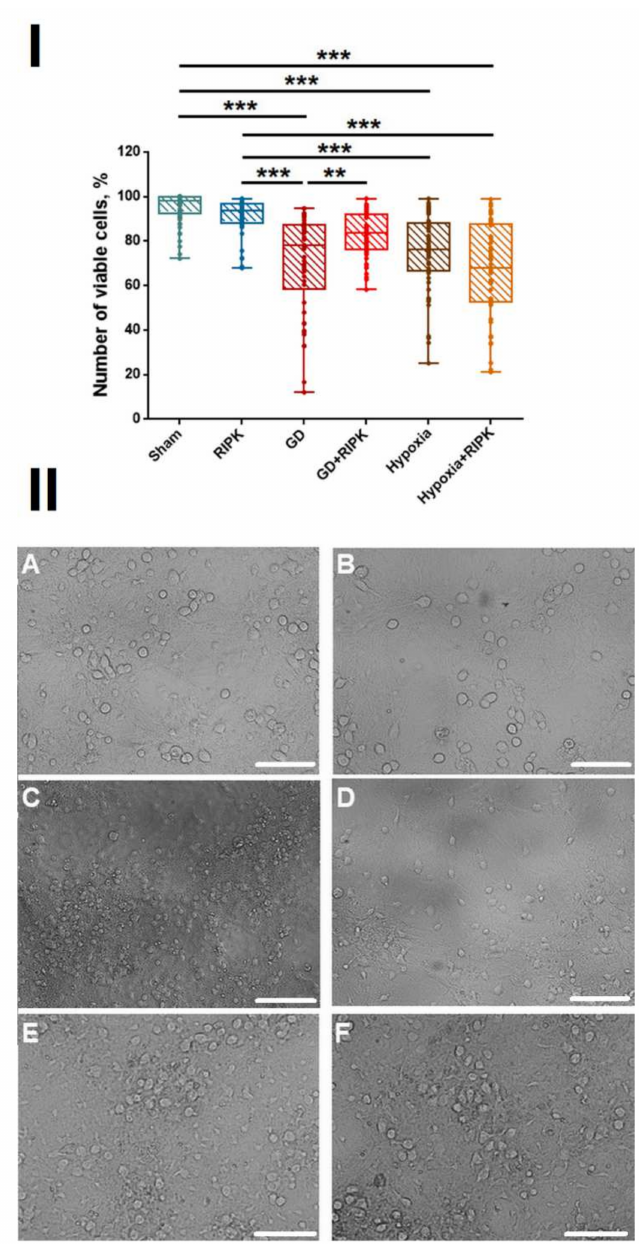
Figure 1. Cell viability of primary hippocampal cultures on day 7 posthypoxia or post-GD modeling. ( I )—analysis of cell viability. ** p ≤ 0.01, *** p ≤ 0.001. Two-way ANOVA followed by Bonferroni post-hoc test for multiple comparisons. F = 27.79. Sham vs. RIPK—NS; Sham vs. GD p ≤ 0.001; Sham vs. GD + RIPK p = 0.004; GD vs. GD + RIPK p = 0.008; Sham vs. Hypoxia p ≤ 0.001. Sham vs. Hypoxia + RIPK p ≤ 0.001; Hypoxia vs. Hypoxia + RIPK NS. ( II )—Representative examples of morphological changes in primary hippocampal cell cultures on day 7 after modeling ischemic factors. ( A )—Sham, ( B )—RIPK1, ( C )—Glucose Deprivation, ( D )—GD + RIPK1, ( E )—Hypoxia, ( F )—Hypoxia + RIPK1. Scale bar 50